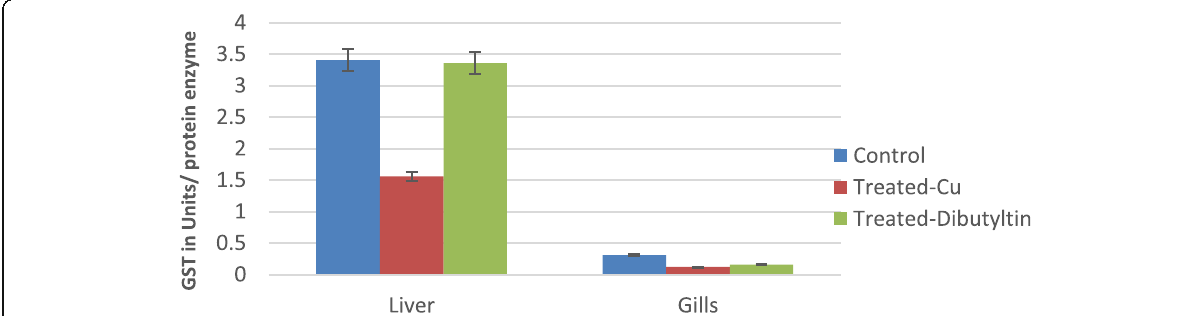
Fig. 7 Average GST content in tilapia in the liver and gills in control, Cu-treated, and dibutyltin-treated. Data were expressed as mean and error